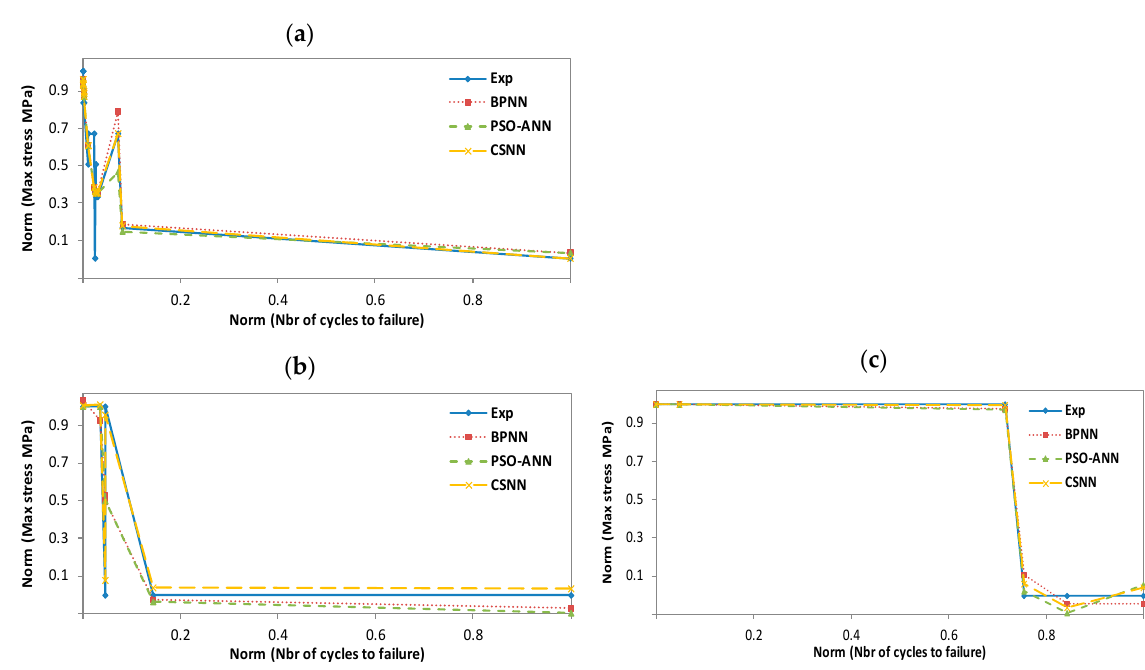
( b ) ( c ) Figure 14. Experimental and predicted values of vinyl ester resin fatigue life (Derakane 411C-50). ( a ): T = 50 °C wet; ( b ): T = 20 °C dry; ( c ): T = 20 °C wet. In all these figures, it can be noted that the prediction plots follow their experimental reference, which demonstrates the efficiency of the combinations we propose. However, the CSNN plot is almost superimposed on that of the experimental, because of its simplic- ity in using mathematical models in comparison with PSO-ANN, as well as its ability to adjust weights without determining a gradient by comparing with BPNN. In the training